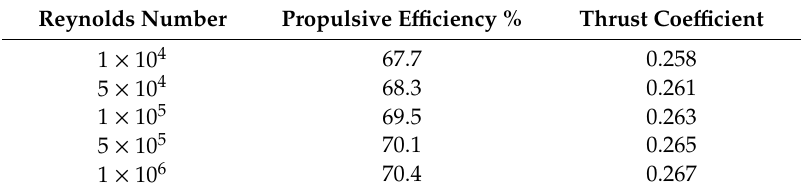
Table 4. Reynolds numbers in the preliminary investigation.